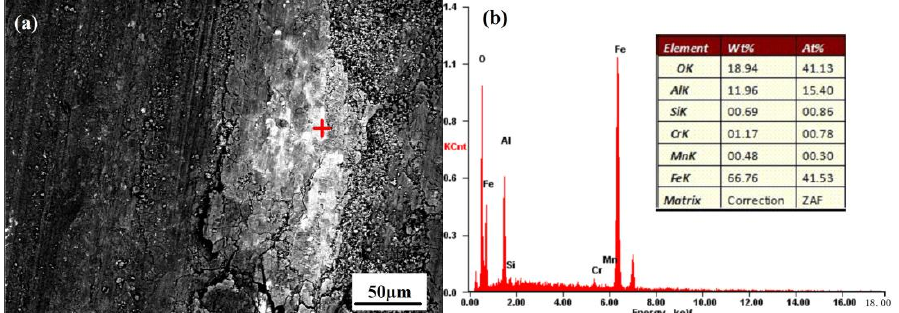
Figure 4. Energy dispersive X ‐ ray (EDX) analysis of the rheoformed composite parts at a semisolid stirring temperature of 620 °C: ( a ) SEM micrograph and ( b ) distribution of elements.